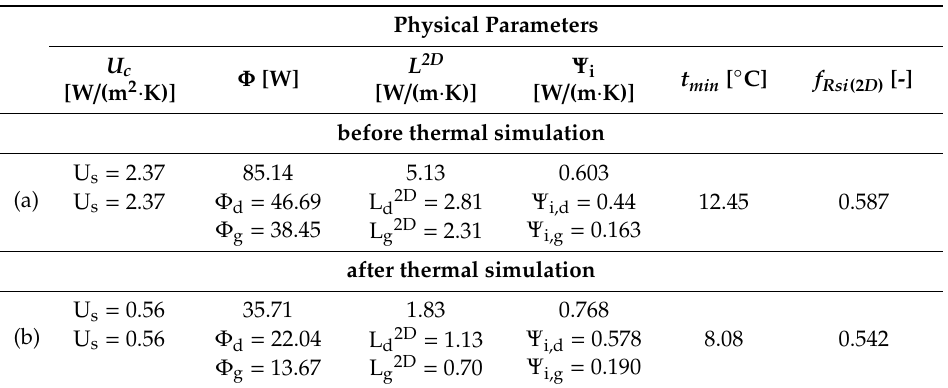
Table 10. Physical parameters obtained by the simulation.